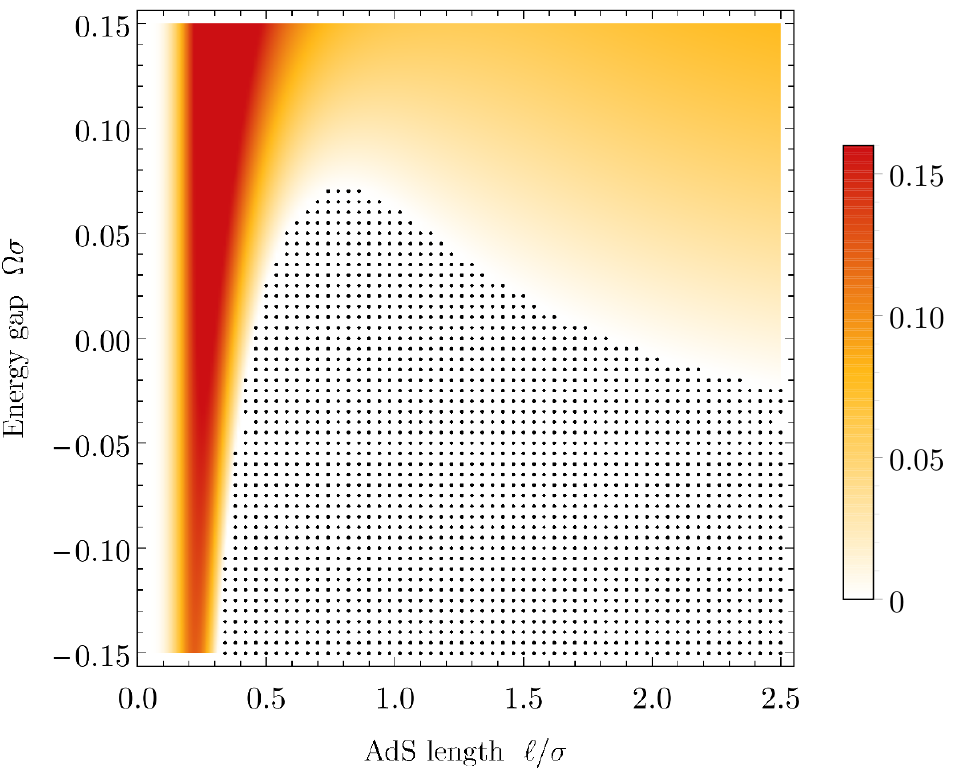
Figure 16 . A density plot of the concurrence C = ~ (cid:21) 2 as a function of the energy gap of the detectors and AdS length for the particular case of d ( R A ; R B ) =(cid:27) = 1 and Neumann boundary conditions ( (cid:16) = (cid:0) 1). The black dots indicate regions where the concurrence is precisely zero and no entangle- ment harvesting is